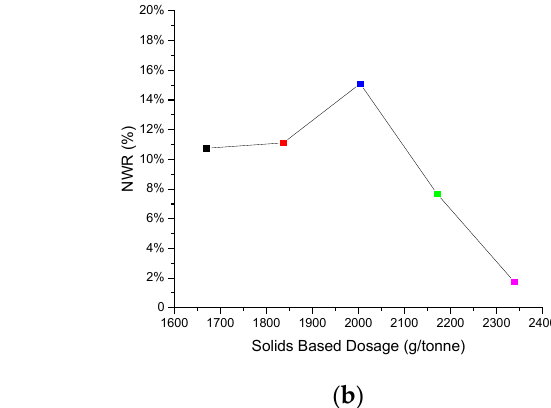
Figure 8. ( a ) Torque profiles of the flocculation on A3338-treated FFT-4 with different dosages; ( b ) the NWR results corresponding to the torque profiles of the flocculation.